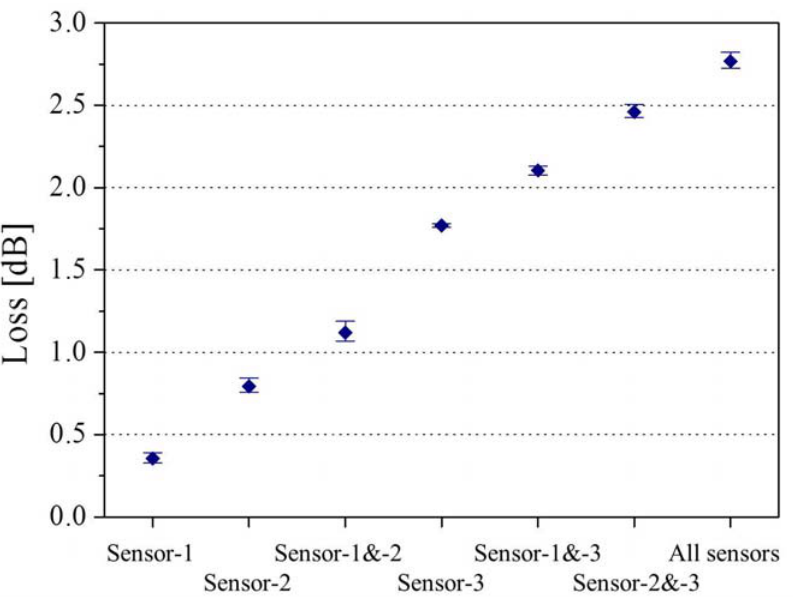
Figure 7. The average of optical loss of each pattern with these five